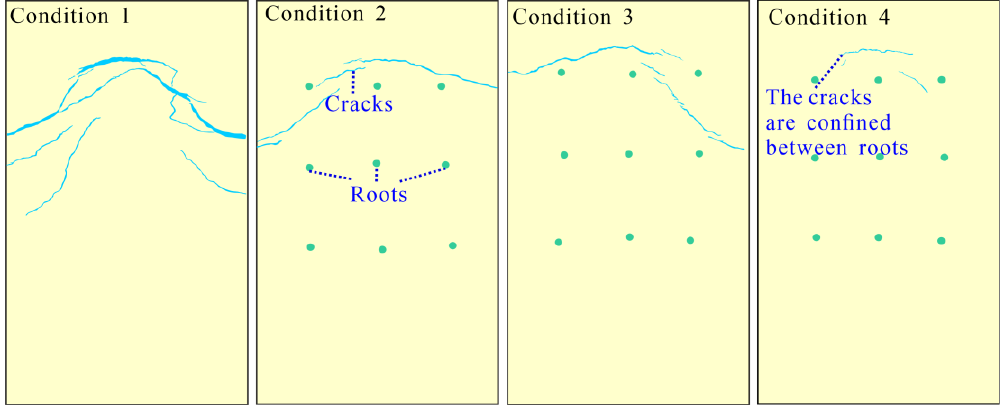
Figure 13. Cracks at 240 s of the four conditions.